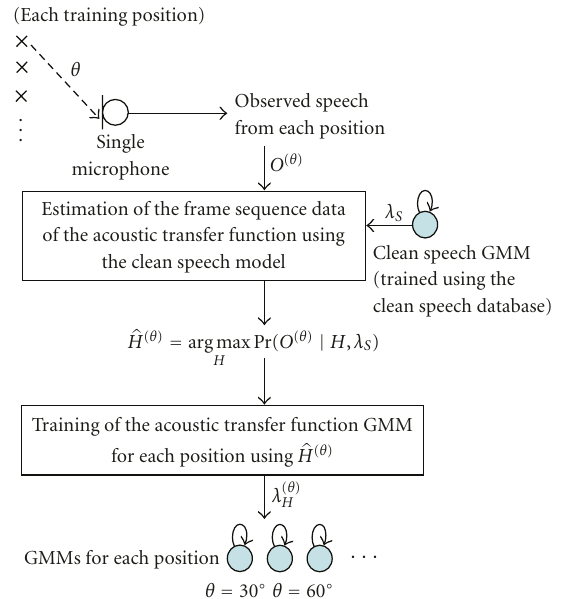
Figure 1: Training process for the acoustic transfer function GMM.